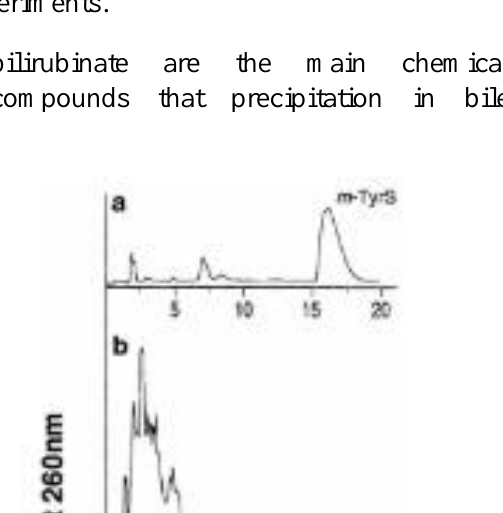
Fig 1. Urinary DL -m-TyrS, was